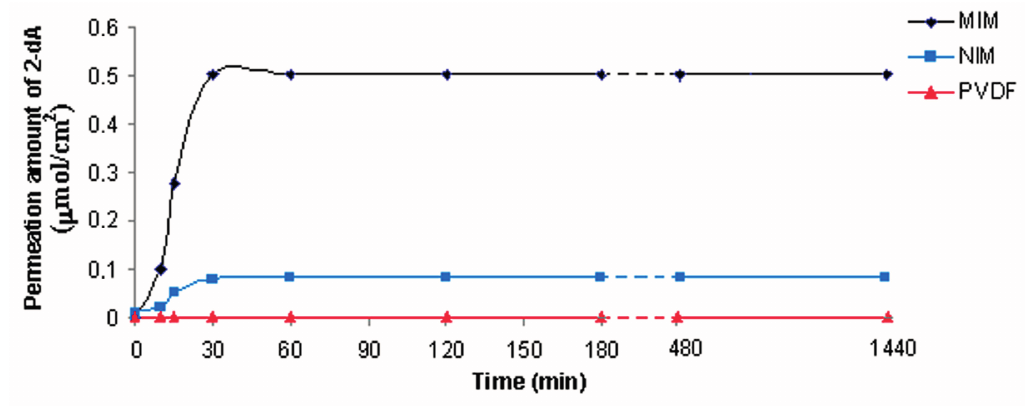
Figure 4. Kinetic study for 2-dA sorption of MIM, NIM and PVDF